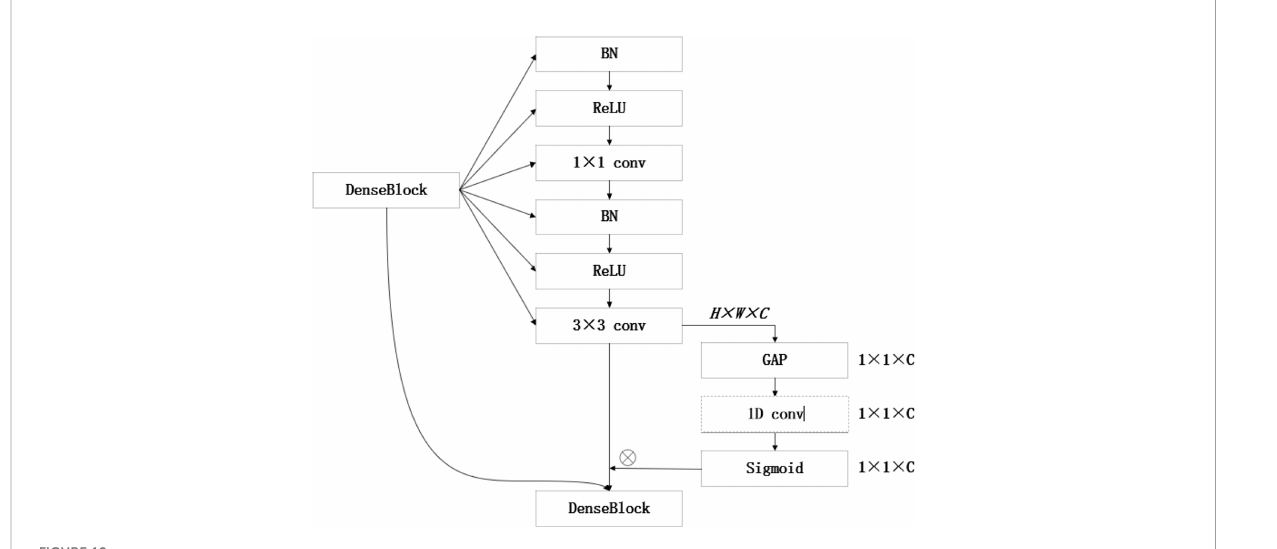
FIGURE 10 The ECA DenseBlock structure diagram.